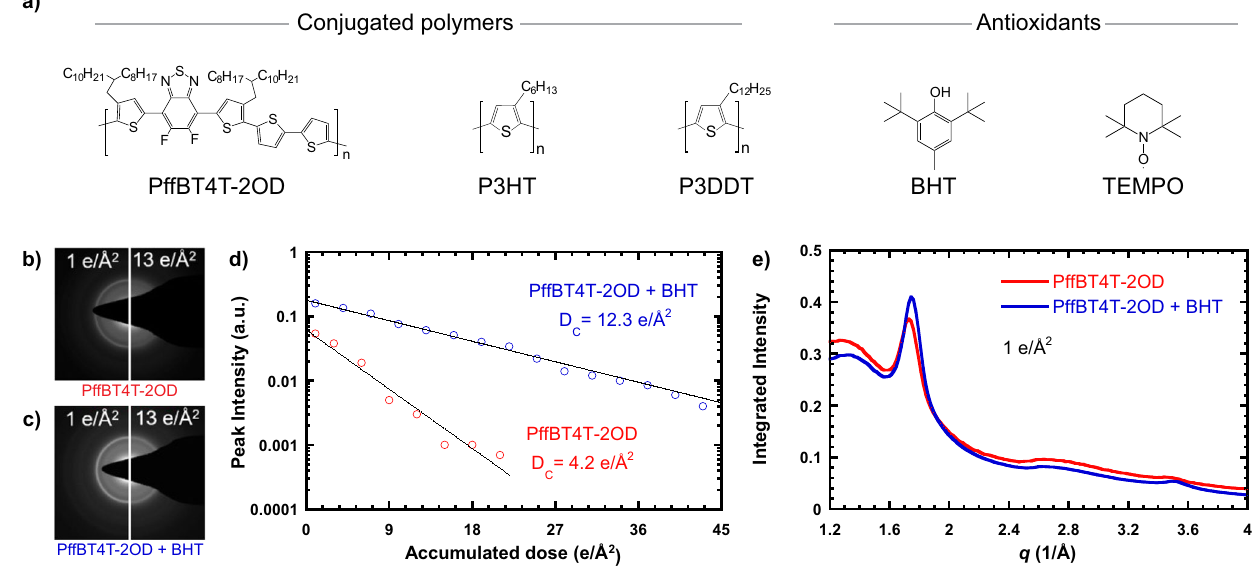
Fig. 1 Chemical structures and minimization of beam damage by the addition of BHT at a dose rate of 1 e/Å 2 s at room temperature. ( a ) Chemical structures of conjugated polymers and antioxidants used in this study. ( b ) Electron diffraction pattern of neat PffBT4T-2OD at low and high dose, showing loss of crystal structure after an accumulated dose of 13 e/Å 2 . ( c ) Electron diffraction pattern of PffBT4T-2OD + BHT at low and high dose, showing partially preserved crystal structure at 13 e/Å 2 . ( d ) Background subtracted peak intensity vs. accumulated dose for PffBT4T-2OD and PffBT4T-2OD + BHT with exponential fi ts showing persistence of crystal structure to higher dose with the addition of BHT. ( e ) Azimuthal integration of electron diffraction patterns of PffBT4T-2OD with and without BHT at a dose of 1 e/Å 2 , showing no change in crystal structure.